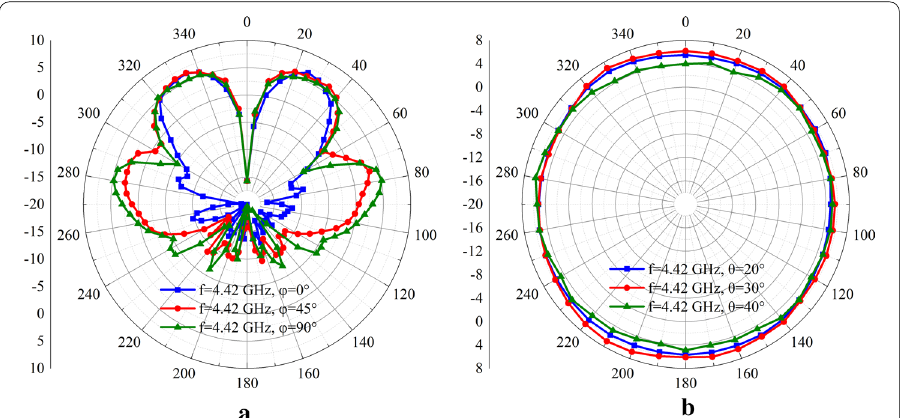
Fig. 10 The radiation pattern of antenna at 4.42 GHz. a Vertical radiation pattern. b Horizontal radiation pattern